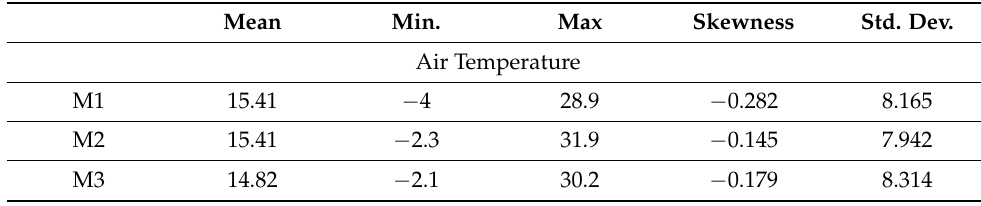
Table 1. The statistical overview of